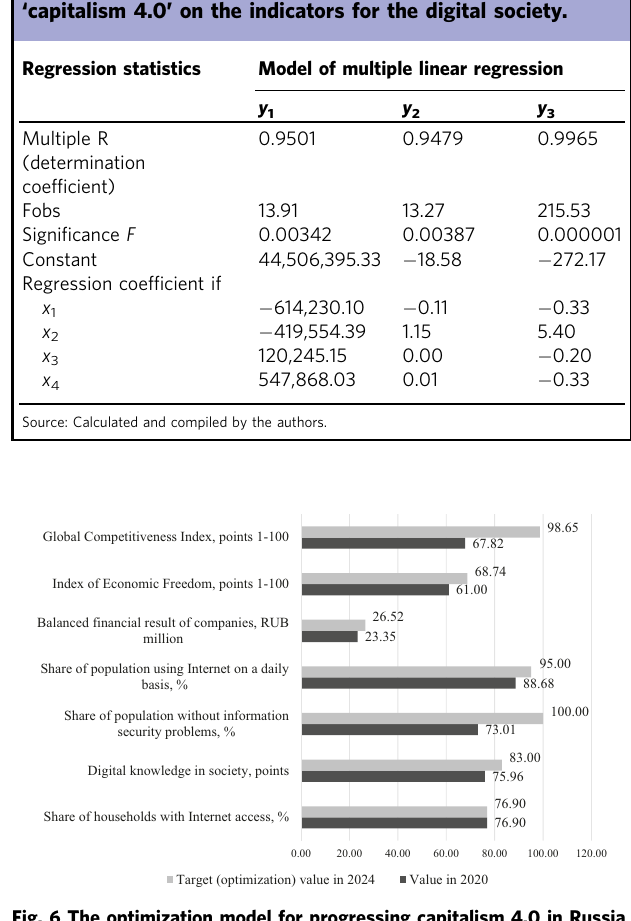
Fig. 6 The optimization model for progressing capitalism 4.0 in Russia through managing the development of the digital society, 2020 – 2024. Source: Calculated and built by the